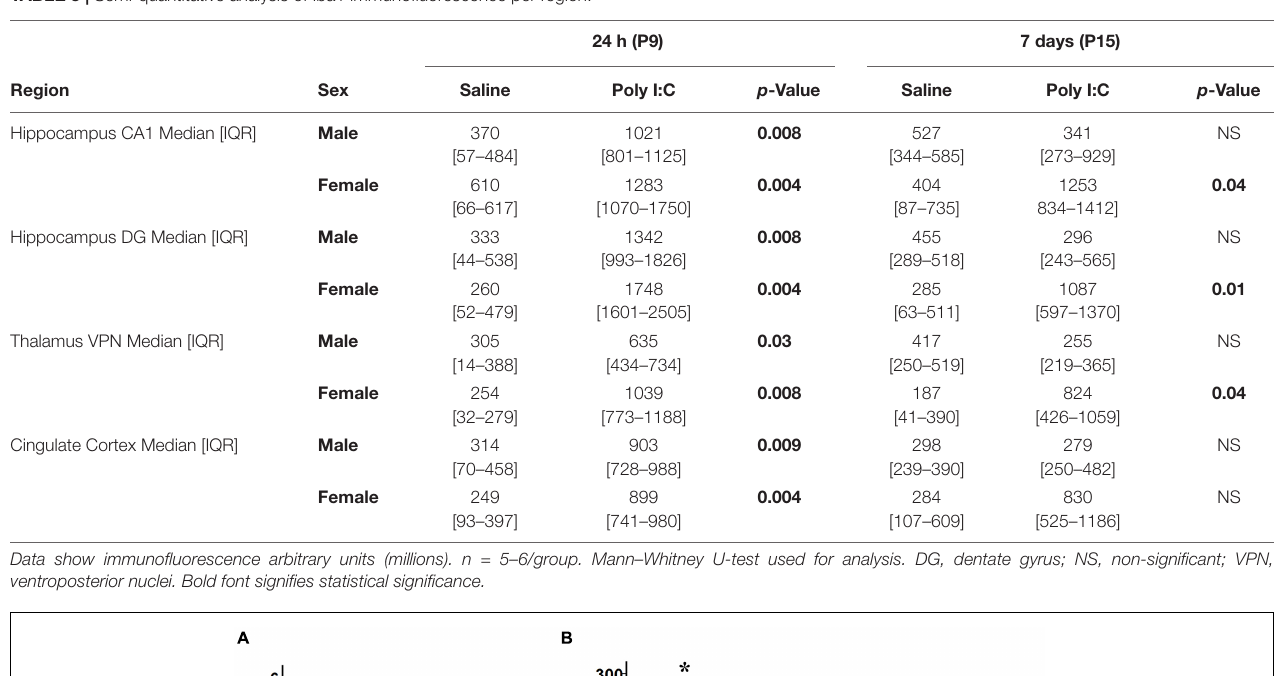
TABLE 3 | Semi-quantitative analysis of Iba1 immunofluorescence per region.